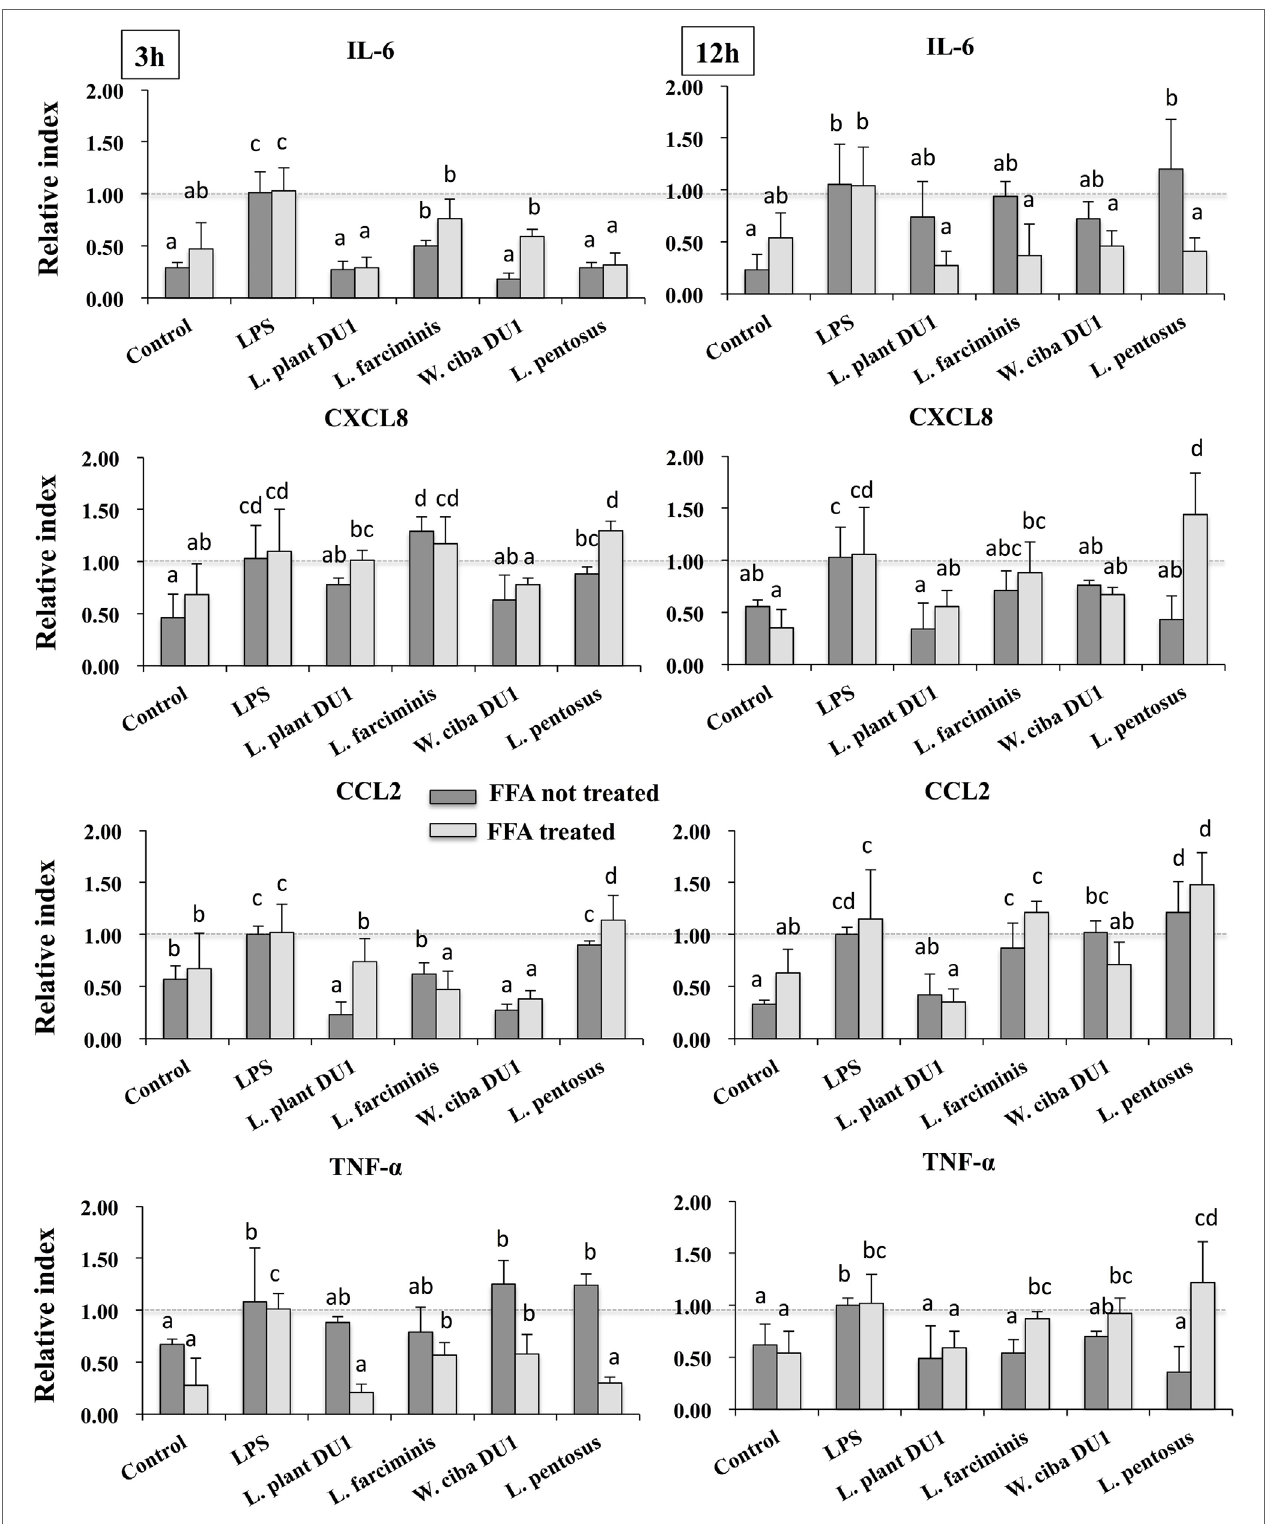
FigUre 2 | Total cellular fluid (TCF) of lactic acid bacteria (LAB) downregulated LPS induced pro-inflammatory cytokines/chemokine in HepG2 cells. Confluence HepG2 cells were pre-stimulated with LAB TCF (50 µl/ml) for 48 h, then stimulated with LPS for 3 and 12 h. The mRNA levels of IL-6, CXCL8, CCL2, and TNF- α were determined by RT-PCR. HepG2 cells either with medium or LPS was used as control. Three independent experiments were performed and the mean value was presented as anti-inflammatory effect of LABs. Different superscript letters indicate significant differences at the 0.05